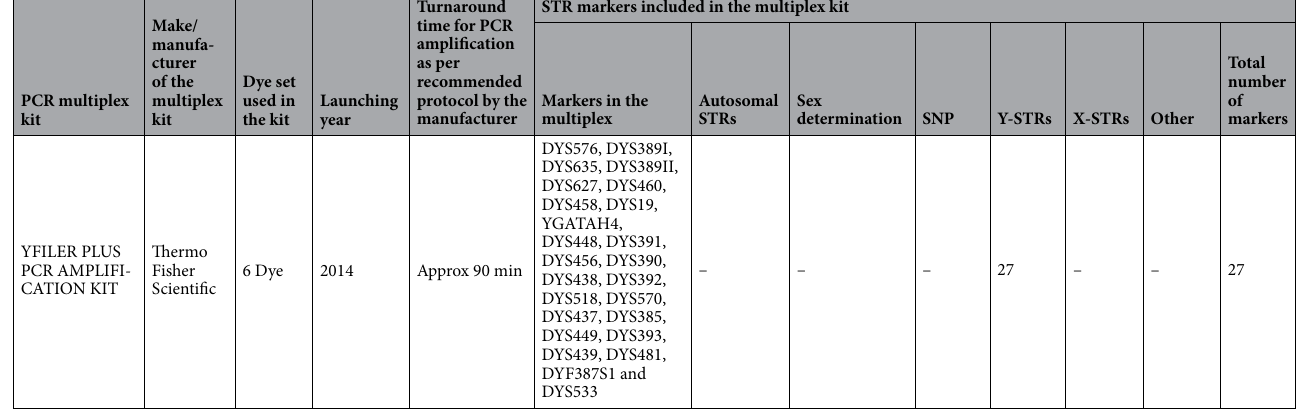
Table 1. Comparative list of various multiplex kits.